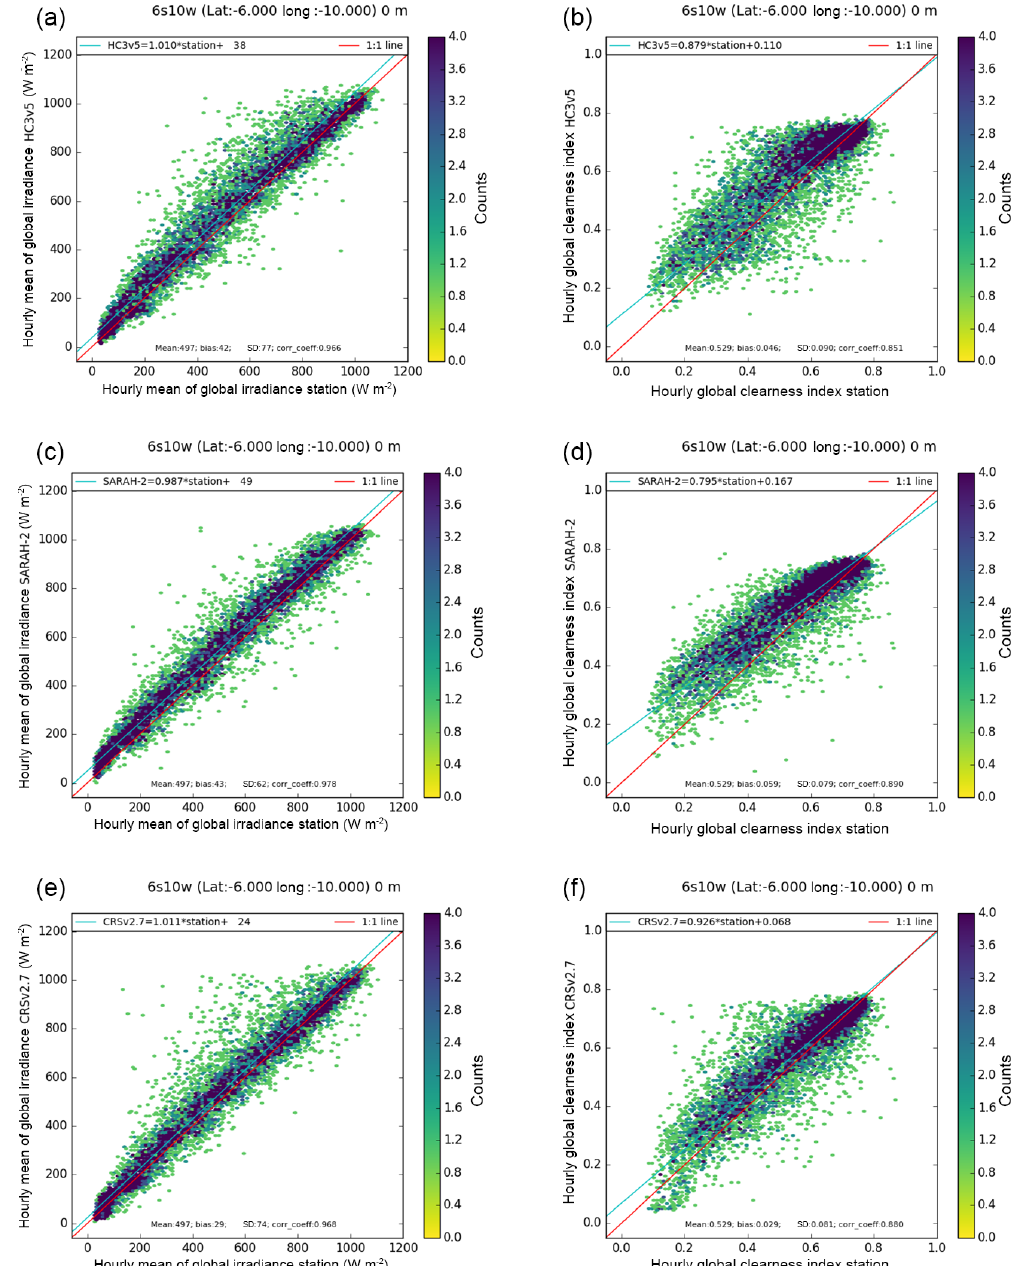
Figure 2. The 2-D histograms of PIRATA measurements (horizontal axis) and data sets (vertical axis) at 6 ◦ S, 10 ◦ W for E and KT. HC3v5: (a) and (b) ; SARAH-2: (c) and (d) ; CRS: (e) and (f) . Ideally, the dots should lie along the red line (1:1 line). The blue line is the affine function fitted over the points and should ideally overlay the red